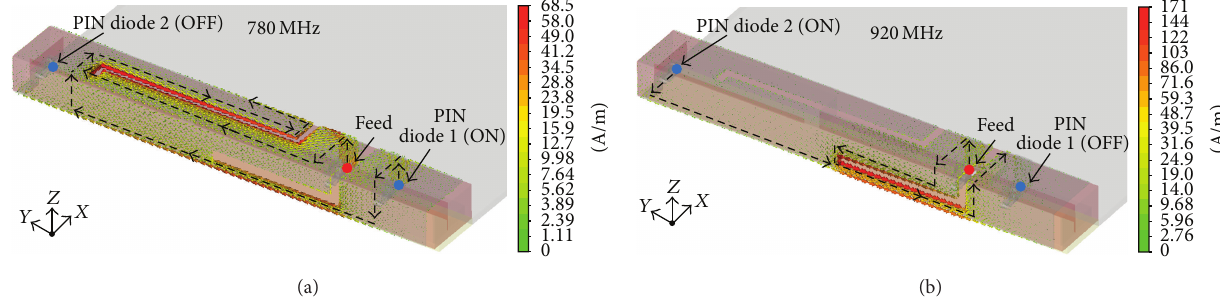
Figure 10: Simulated surface current distribution of the proposed antenna: (a) at 780 MHz (State 1) and (b) at 920 MHz (State 2).